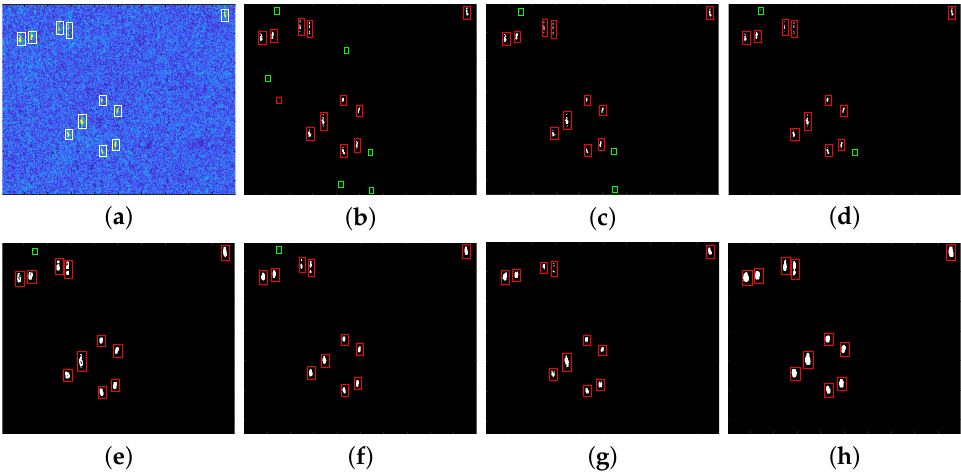
Figure 8. Detection results of different methods for scene 2. ( a ) original image; ( b ) CA-CFAR method; ( c ) G Γ D-CFAR method; ( d ) New LN-2PCFAR method; ( e ) MVWIE method; ( f ) FMPCM method; ( g ) IG method; ( h ) proposed method.